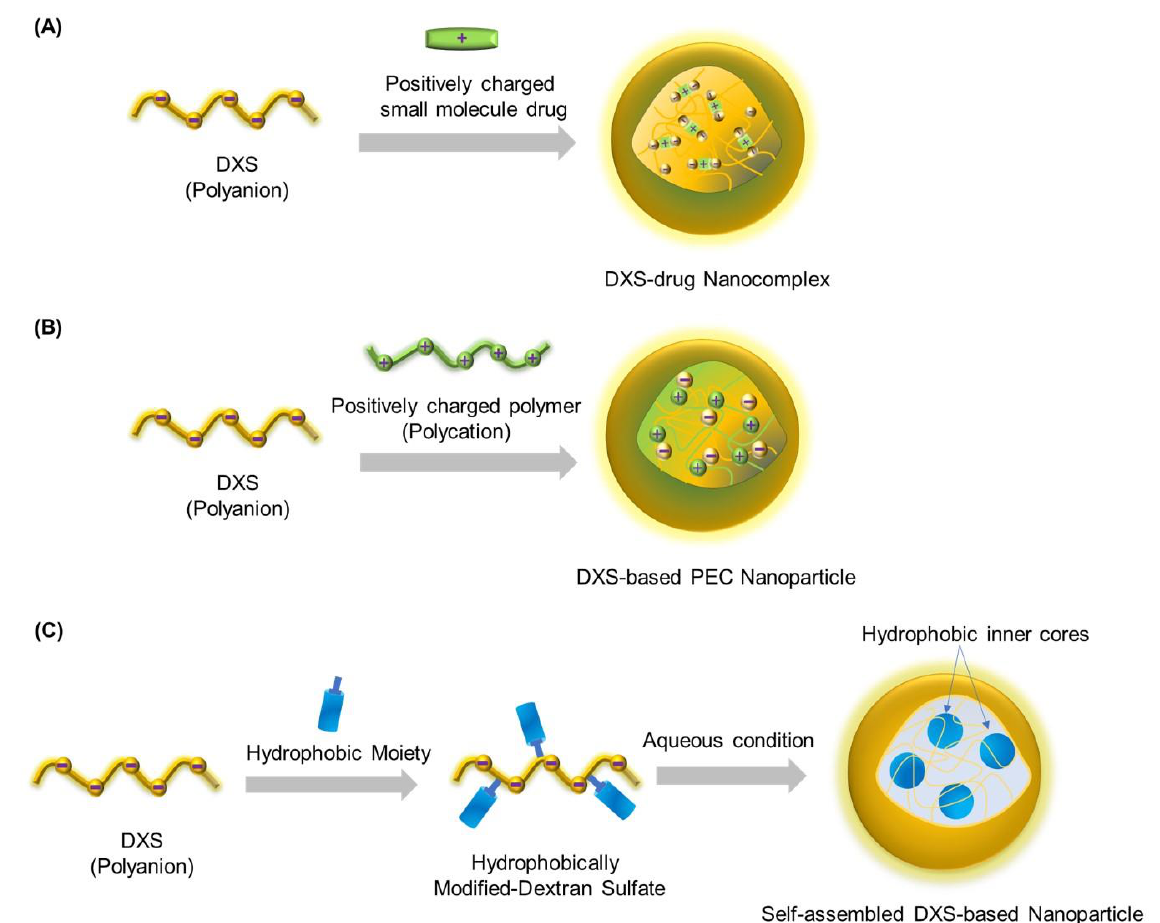
Figure 2. Schematic illustration for the preparation of DXS-based nanoparticles through various mechanisms. ( A ) complexation of DXS and positively charged small molecule drugs, ( B ) complexation of negatively charged DXS and positively charged polymers, and ( C ) self-assembly of hydrophobically modified amphiphilic DXS conjugate.